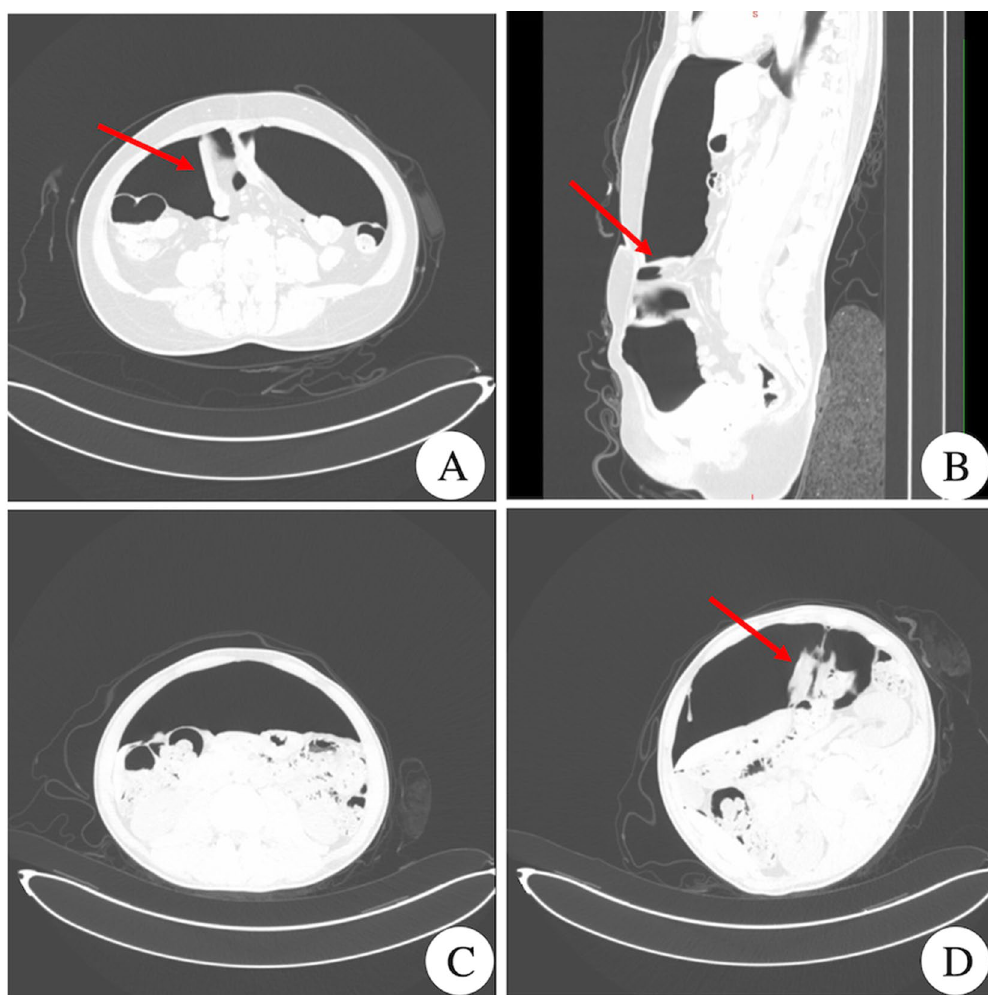
Figure 2. Abnormal pneumoperitoneal space, ( A ) and ( B ) are axial and sagittal pneumoperitoneal images from the same patient. The arrow in the figure shows the small intestine and mesenteric structure that spans the pneumoperitoneal space and connects to the abdominal wall and the visceral plane; ( C ) shows the appearance of a normal pneumoperitoneal space; ( D ) is an image at the same level from the same patient as in ( C ). As shown by the arrow, adhesions of the abdominal organs and left abdominal wall can be seen.